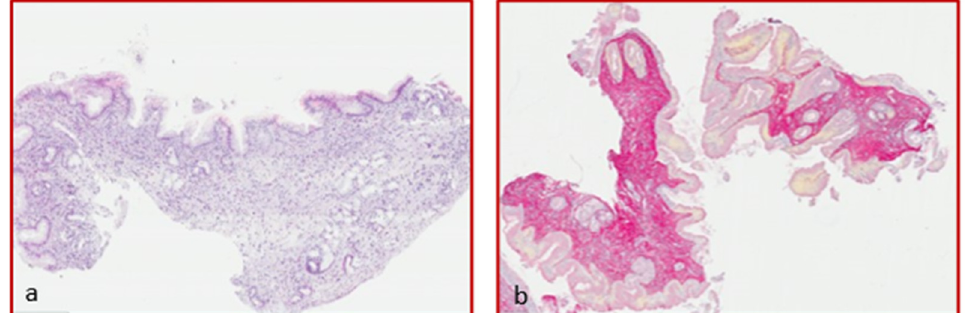
Figure 1. Hematoxylin-eosin staining of an esophageal specimen ( a ) and sirius red ( b ) for collagen quantification (magnification × quantification (magnification ×4).